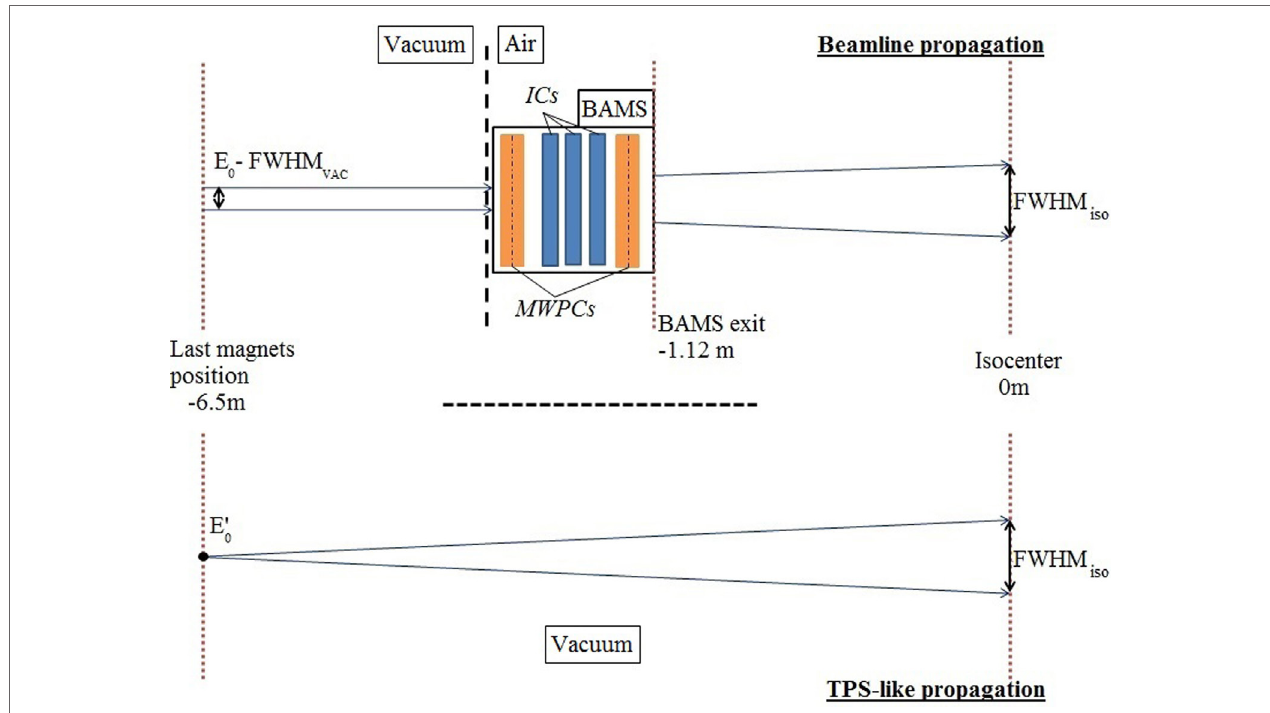
FigUre 1 | schematic of different Mc approaches for simulation transport: on the upper panel, the detailed beamline allowing precise description of the particle interactions, from a beam with an initial energy E 0 and an initial focus FWhM vac ; on the bottom panel the simplified TPs-like approach propagating the particle in vacuum to the isocenter, with an initial energy E ′ 0 taking into account the energy reduction of E 0 due to the BaMs water equivalent thickness and adapted geometrically to the same FWhM iso used by the TPs at isocenter